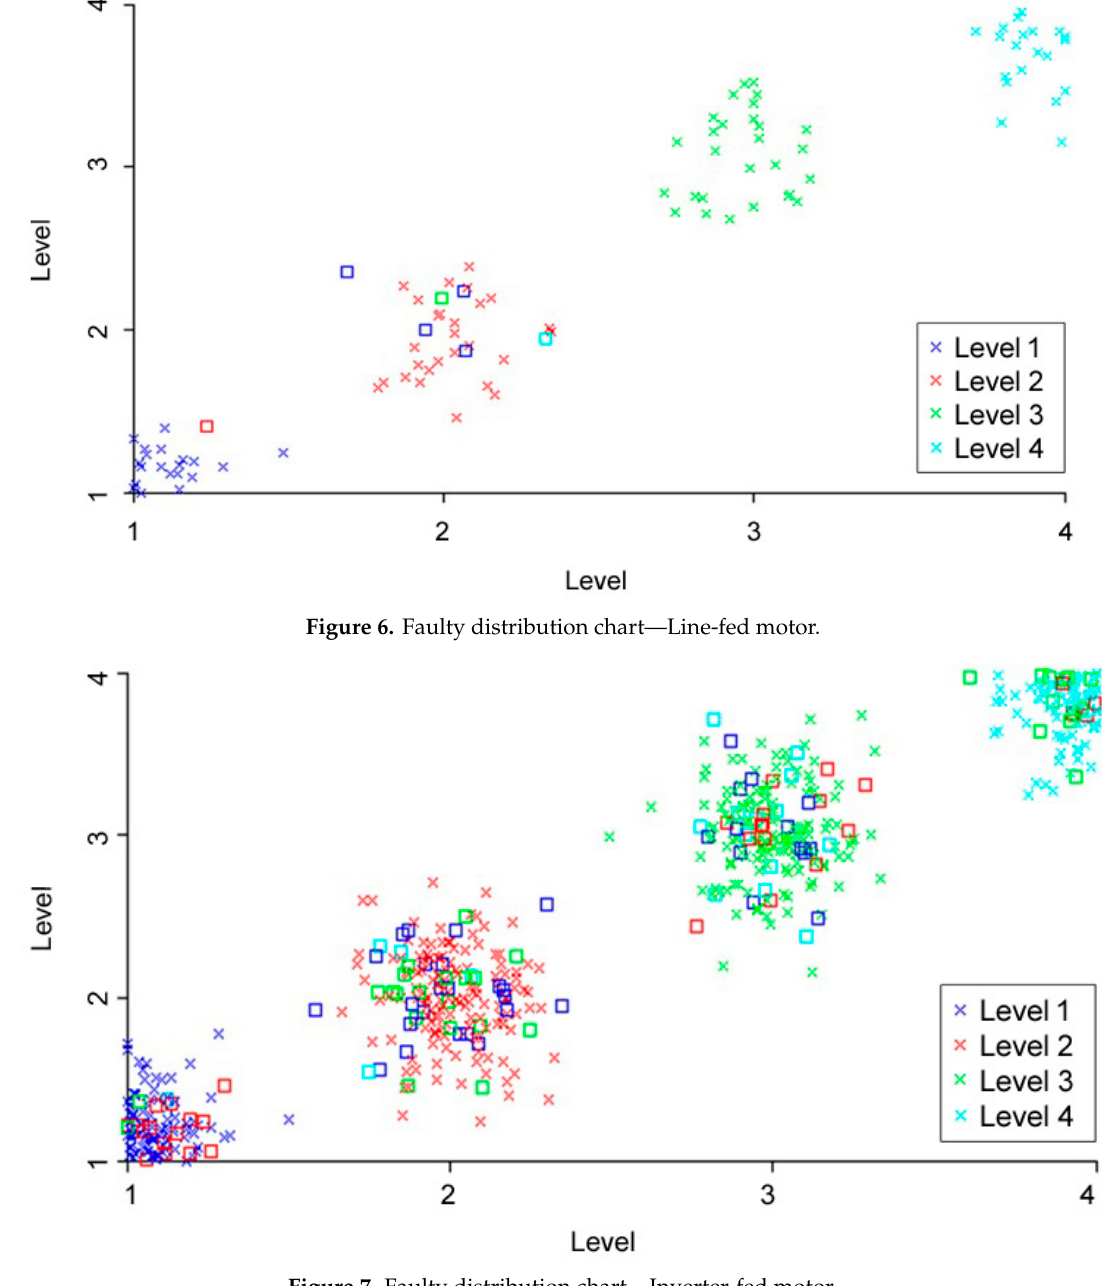
Figure 7. Faulty distribution chart–Inverter-fed motor.